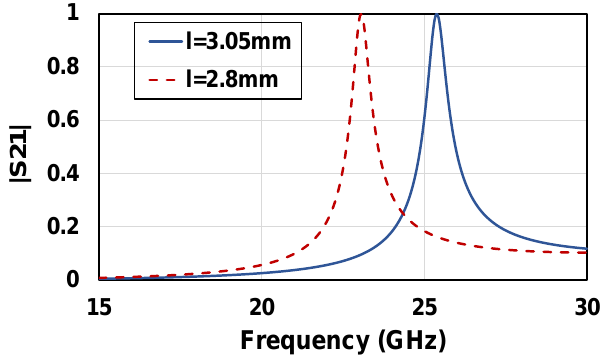
Fig.9. Effect of change in length of metallic wire on magnitude of transmission coefficient